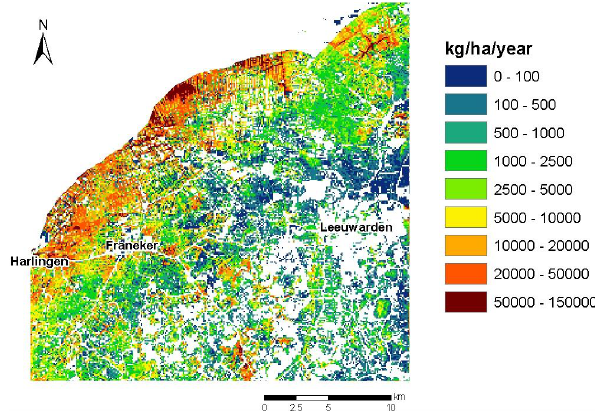
Figure 18 Salt load discharging from the groundwater into the surface water in the summer of 2005.